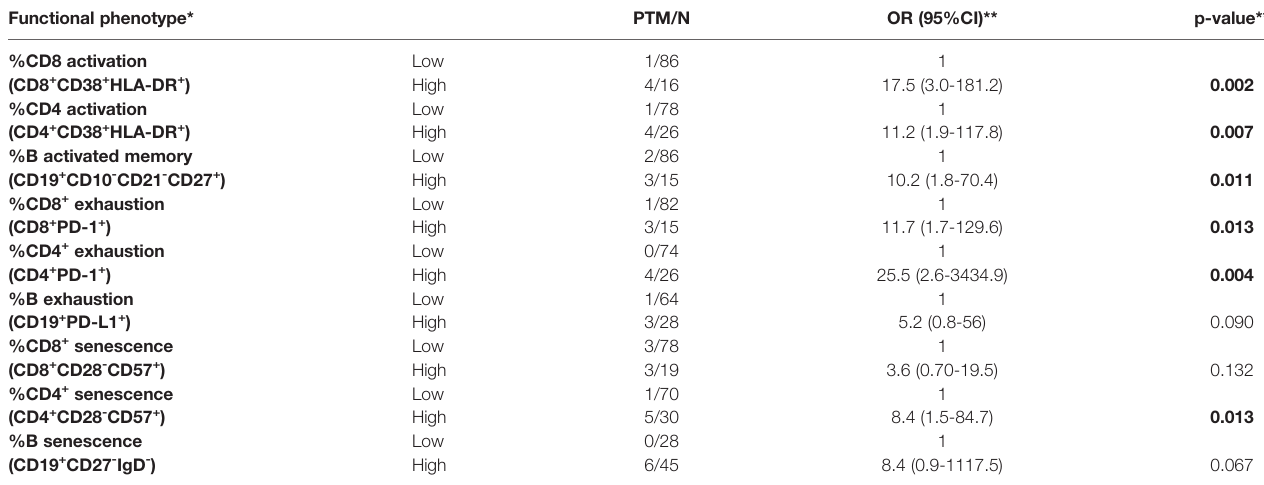
TABLE 3 | Logistic model evaluating the immunological parameters associated with PTM at baseline. Functional phenotype*